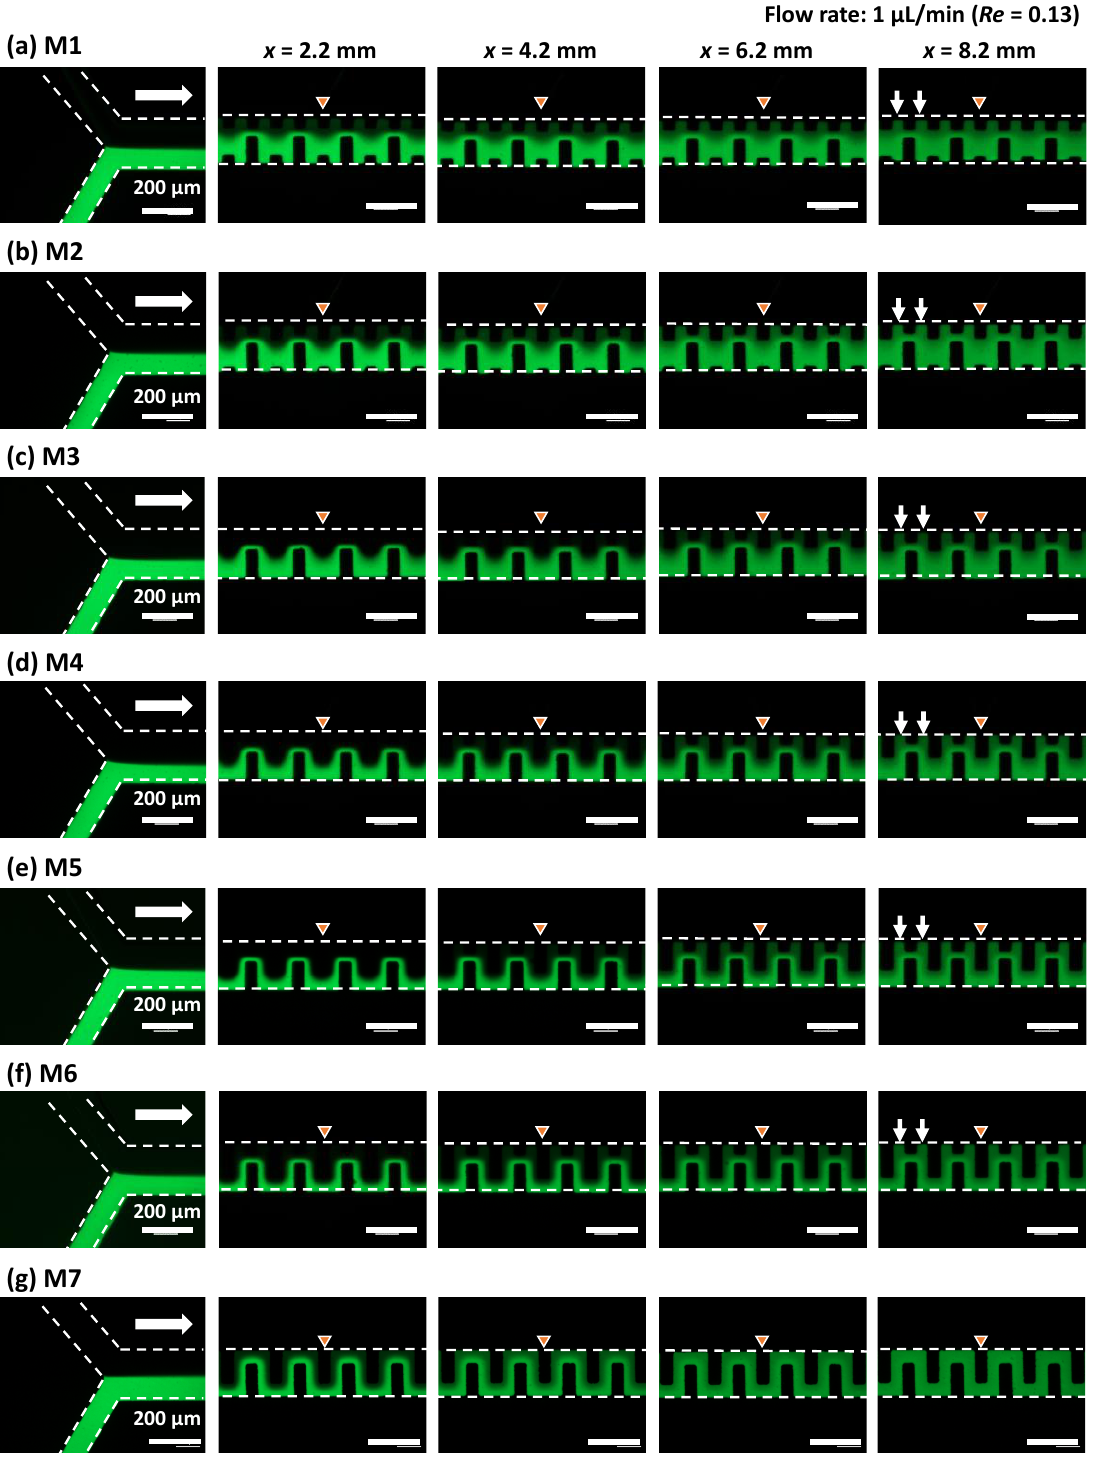
Figure 7. Experimental investigation of the mixing behaviors of six different types of asymmetric micromixers ( a ) M1, ( b ) M2, ( c ) M3, ( d ) M4, ( e ) M5, ( f ) M6, and ( g ) the serpentine micromixer (M7) with a perfectly symmetric mixing unit. Pure water and fluorescein-dyed water (0.1 mol/m 3 ) were introduced at the same flow rate of 0.5 µL/min (a total flow rate of 1 µL/min and Re = 0.13).